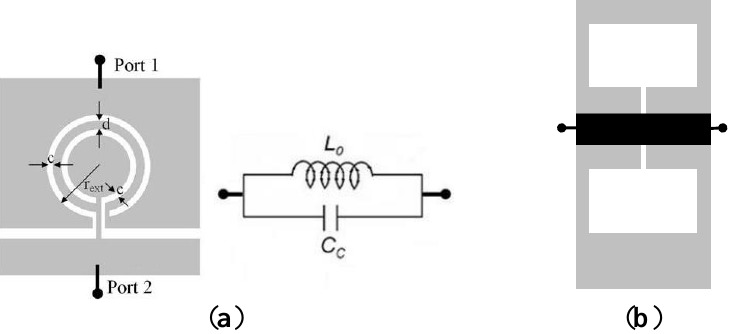
Figure 7. ( a ) Open complementary split ring resonator (OCSRR) topology and its equivalent circuit model. ( b ) Topology of a dumb-bell defected ground structure (DB-DGS) etched in a ground plane of a microstrip transmission